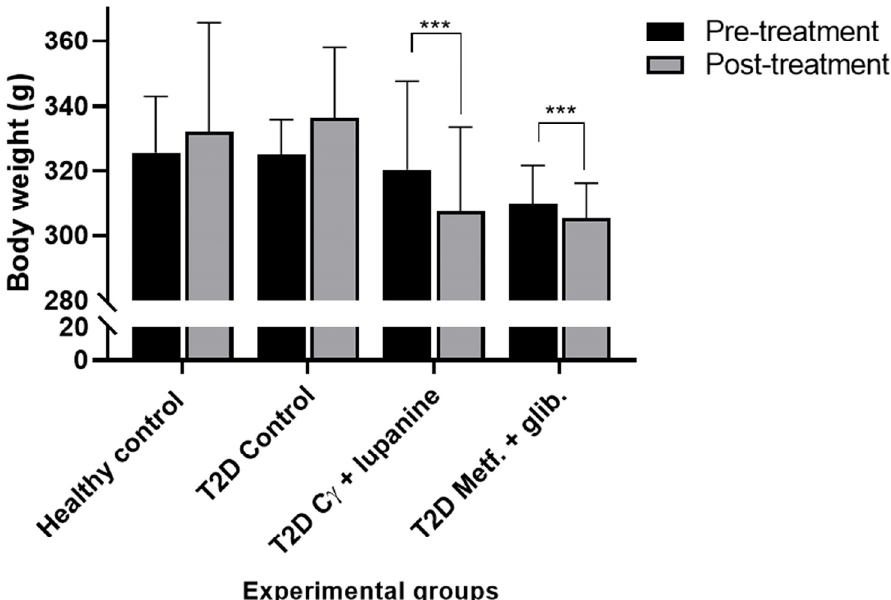
Figure 3. Comparison of body weight change among the experimental diabetic groups. In the untreated groups (healthy and diabetic animals), the body weight increased by 13 g and 11 g, respectively. In contrast, T2D rats that received the combination of our compounds showed a diminution of 13 g. Similarly, the rats that received the pharmacological treatment diminished their body weight by 4 g. Paired t ‐ test between the body weight of animals on the first and last day of treatment, n = 10. *** p > 0.0001.